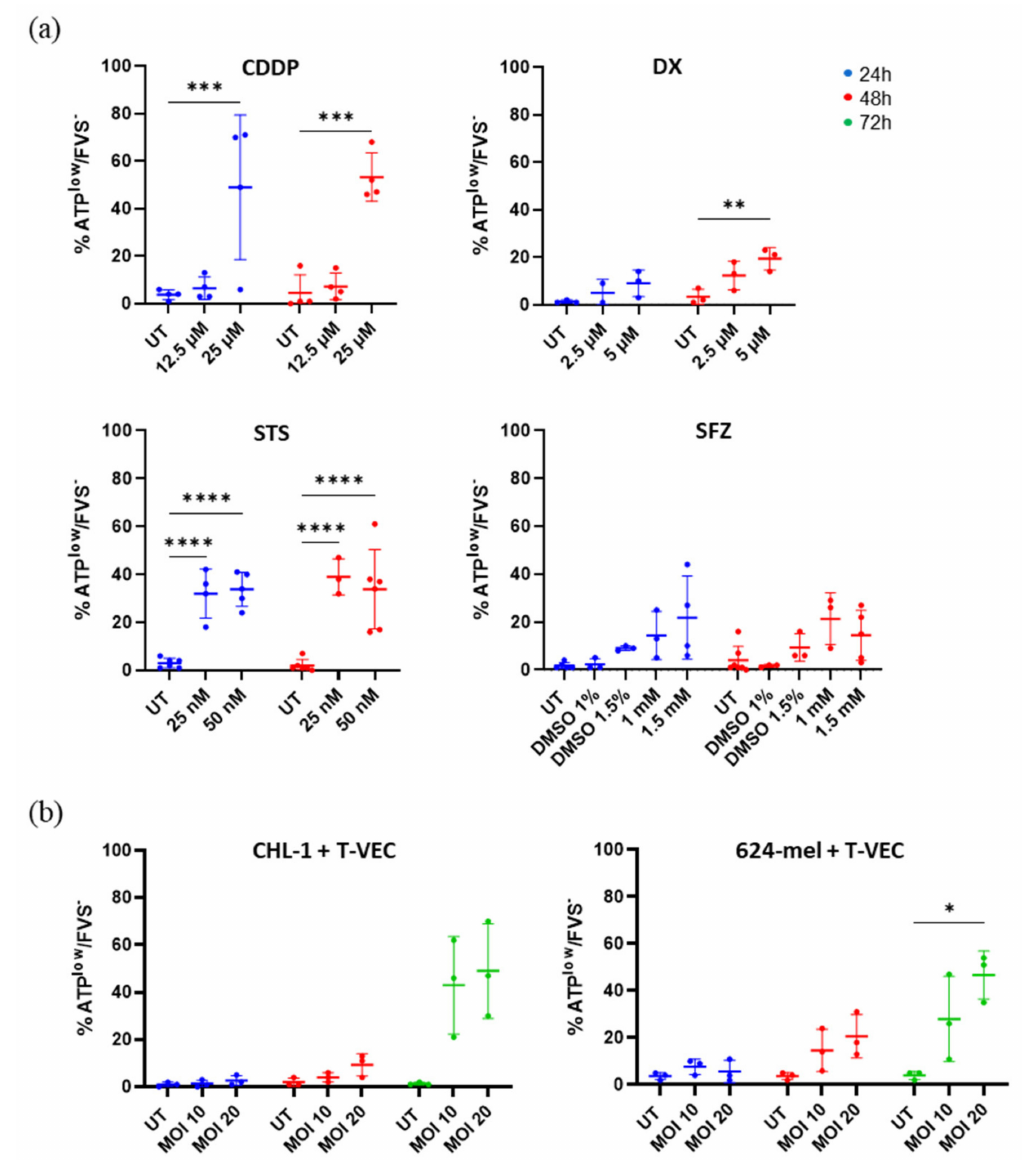
Figure 3. Release of vesicular ATP in response to various treatments. ( a ) CHL-1 cells were treated with CDDP, DX, STS or SFZ for up to 48 h. Within the FVS780 negative population, cells with reduced intracellular ATP (decreased quinacrine signal) were detected by means of flow cytometry. ( b ) CHL-1 or 624-mel cells were treated with T-VEC for up to 72 h. Within FVS780 negative population, cells with reduced intracellular ATP were detected by means of flow cytometry. Data display at least three repeats of independent experiments. Data were analyzed with two-way ANOVA or mixed model with Šid á k corrections. * p < 0.05; ** p < 0.01, *** p < 0.001 and **** p < 0.0001 Abbreviations: CDDP: cisplatin; DX: doxorubicin; FVS: fixable viability stain; MOI: multiplicity of infection; SFZ: sulfasalazine; STS: staurosporine; T-VEC: Talimogene laherparepvec; UT: